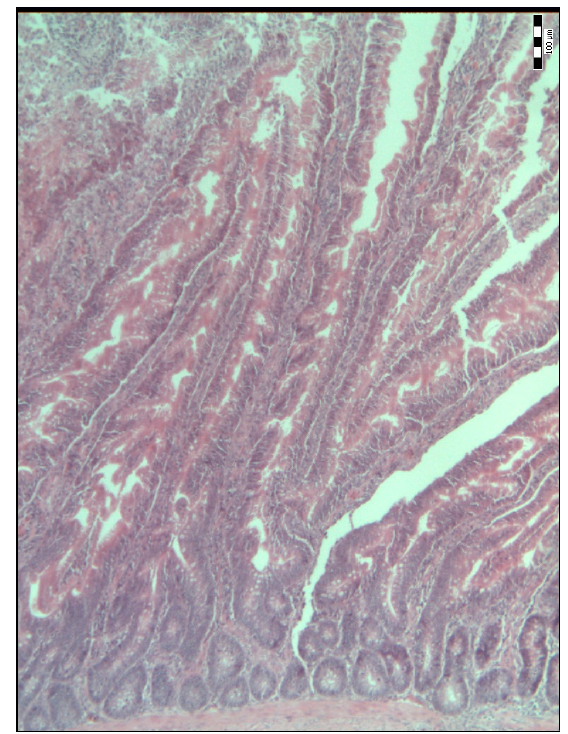
Figure 5. Histological representation of the duodenal villi of broiler chickens from the P4 experimental group of chickens (H&E; ×100).